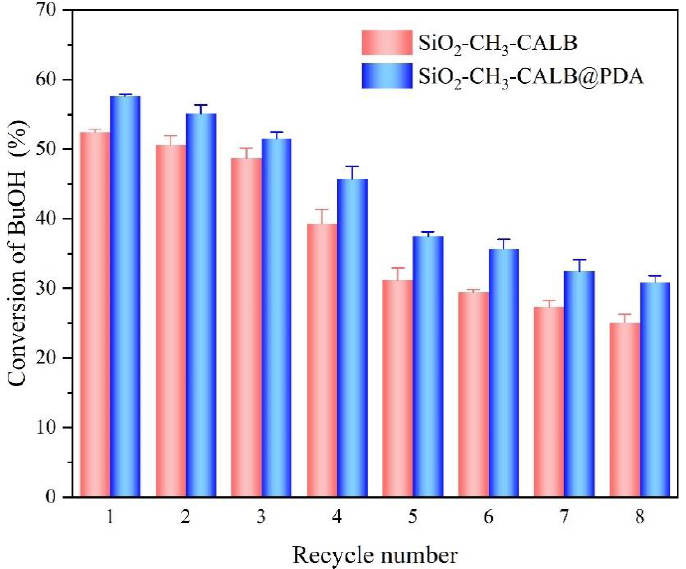
Figure 9. Conversion of n -butanol and repeatability of SiO 2 –CH 3 –CALB and SiO 2 –CH 3 – CALB@PDA.